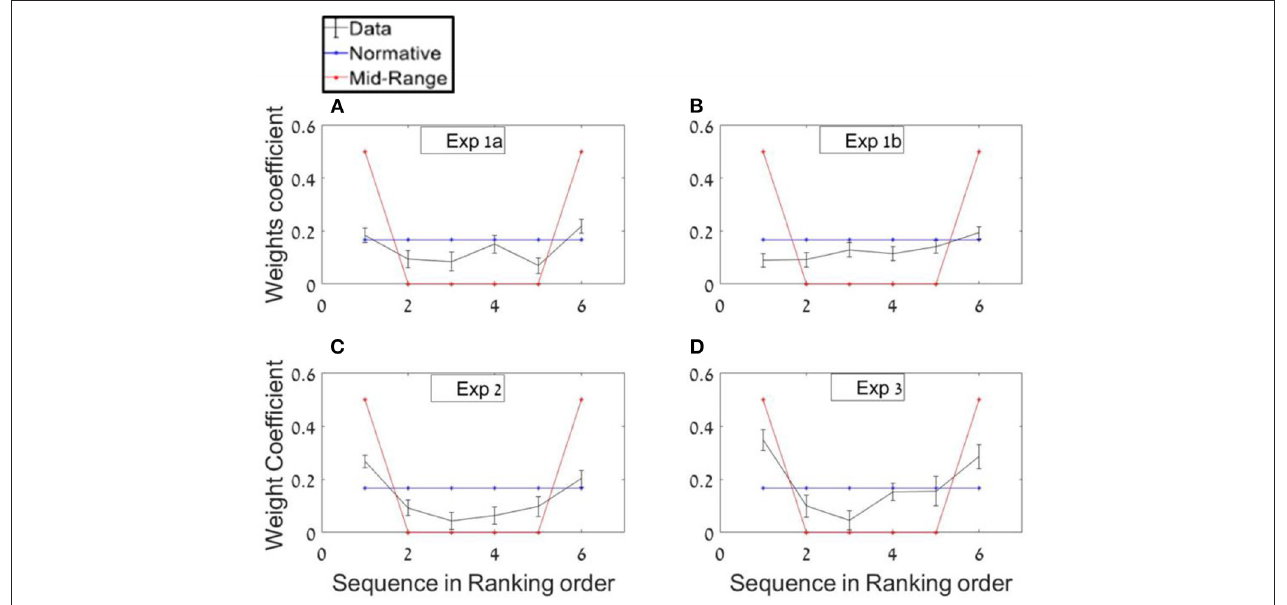
FIGURE 5 | Ranking-weighting profile of the numbers (A) Experiment 1a. Real data regression (black) compared with normative-holistic and mid-range predictions (blue and red, respectively). (B–D) Same analysis for Experiments 1b, 2, and 3,